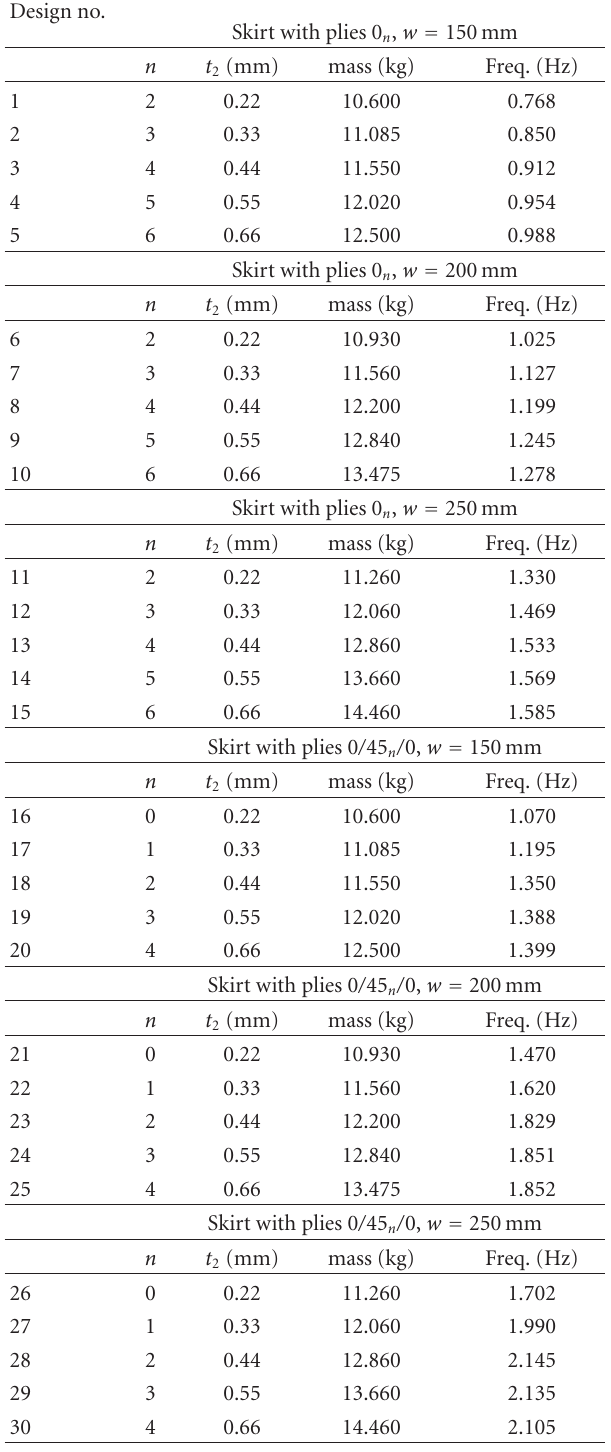
Table 3: Comparison of di ff erent designs of reflective surface with skirt. Design